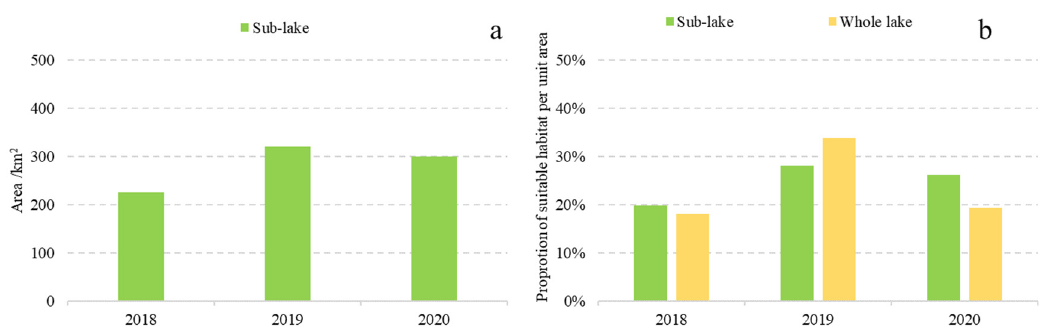
Figure 8. ( a ) Area of suitable sub-lakes habitat in 2018–2020 at Poyang Lake. ( b ) The proportion of suitable habitats per unit area of the sub-lakes and the whole lake in 2018–2020.